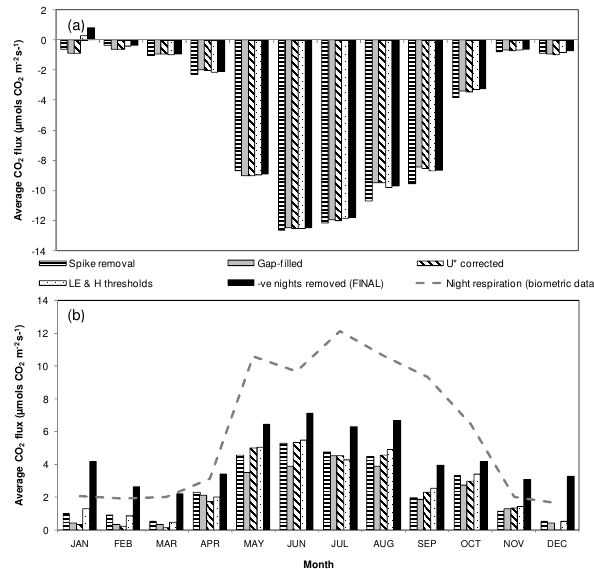
Fig. 4. (a) Day and (b) night-time flux sensitivity attributed with secondary stage processing approaches. Each stage represents cu- mulative processing approaches with increasing constraints upon the flux data, removing “erroneous” results and replacing with gap- filled data. Estimation of respiration from chamber data (soils, stems and leaves) overlay night-time